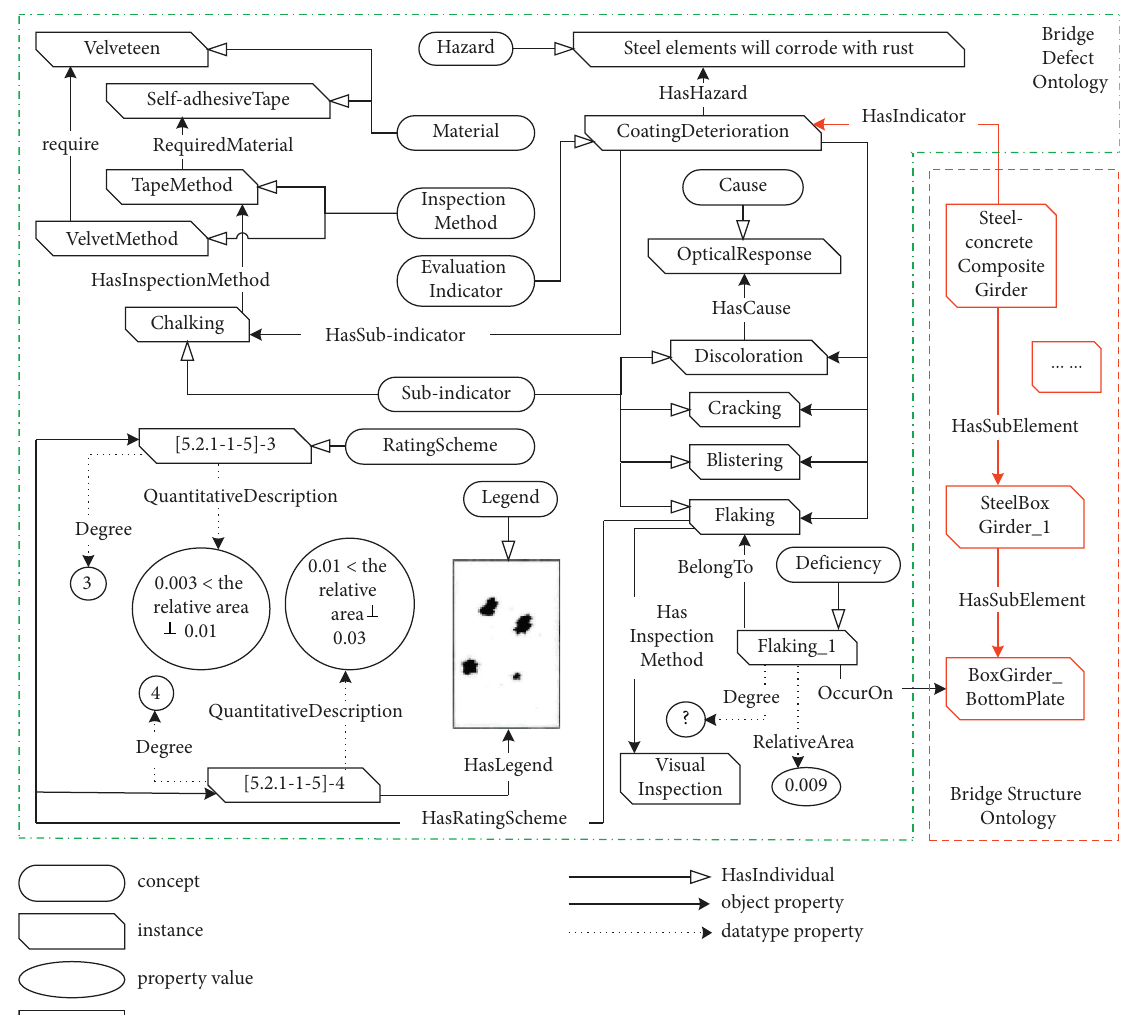
Figure 5: A schematic of the bridge defect ontology (partial